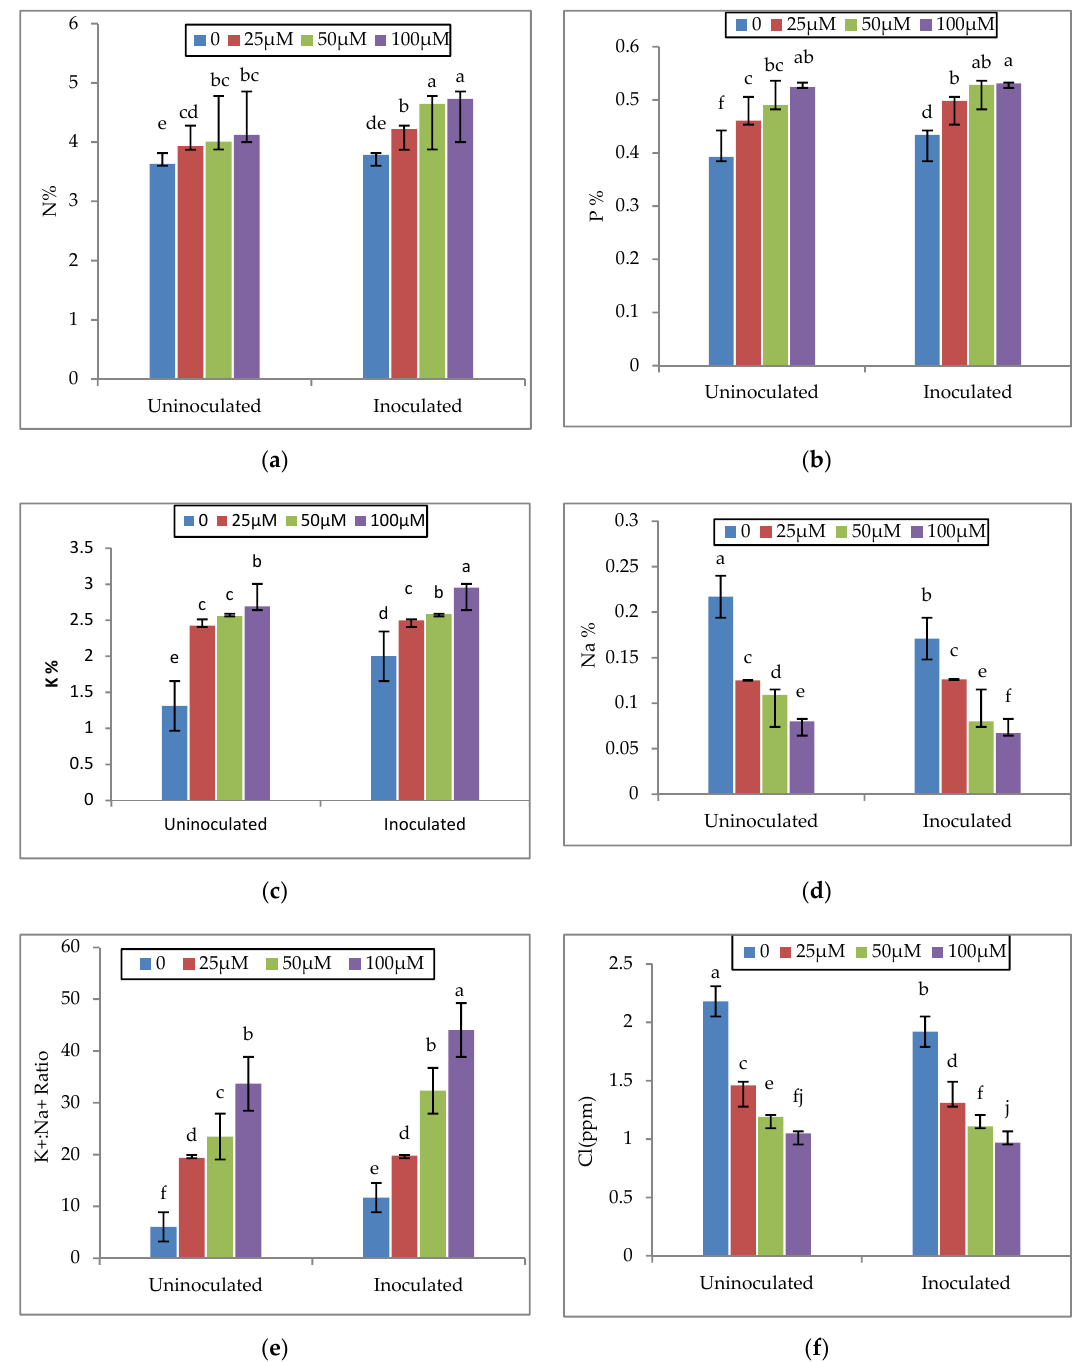
Figure 2. E ff ect of EPS-producing bacteria and melatonin on nutrient concentrations [N% ( a ), P% ( b ), K% ( c ), Na% ( d ) and Cl ppm ( f )] and the K + / Na + ratio ( e ) of faba bean grown in location two